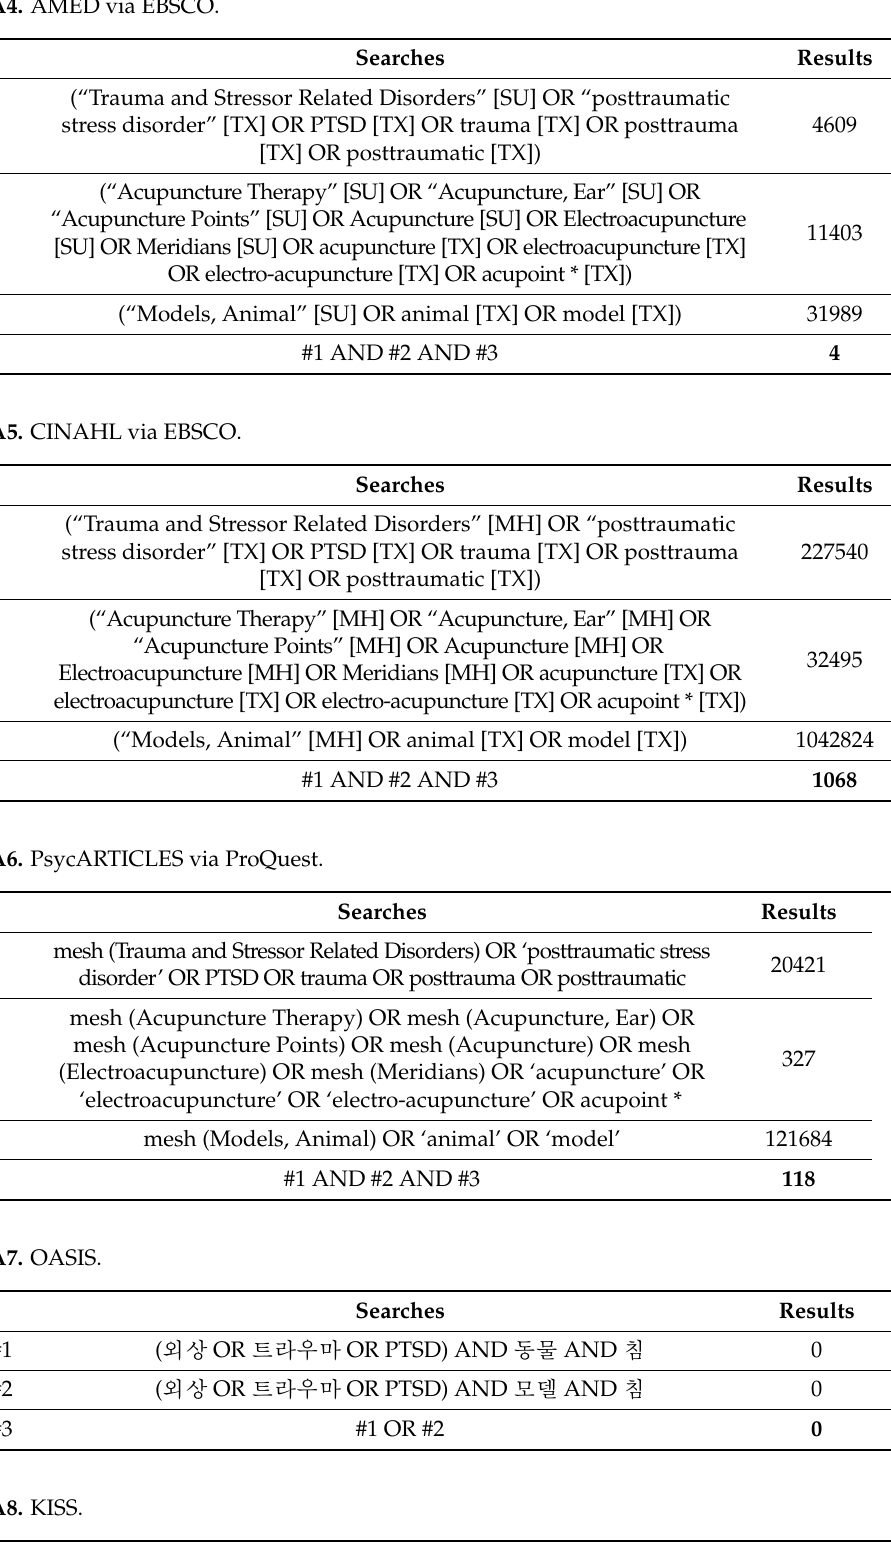
Table A4. AMED via EBSCO.